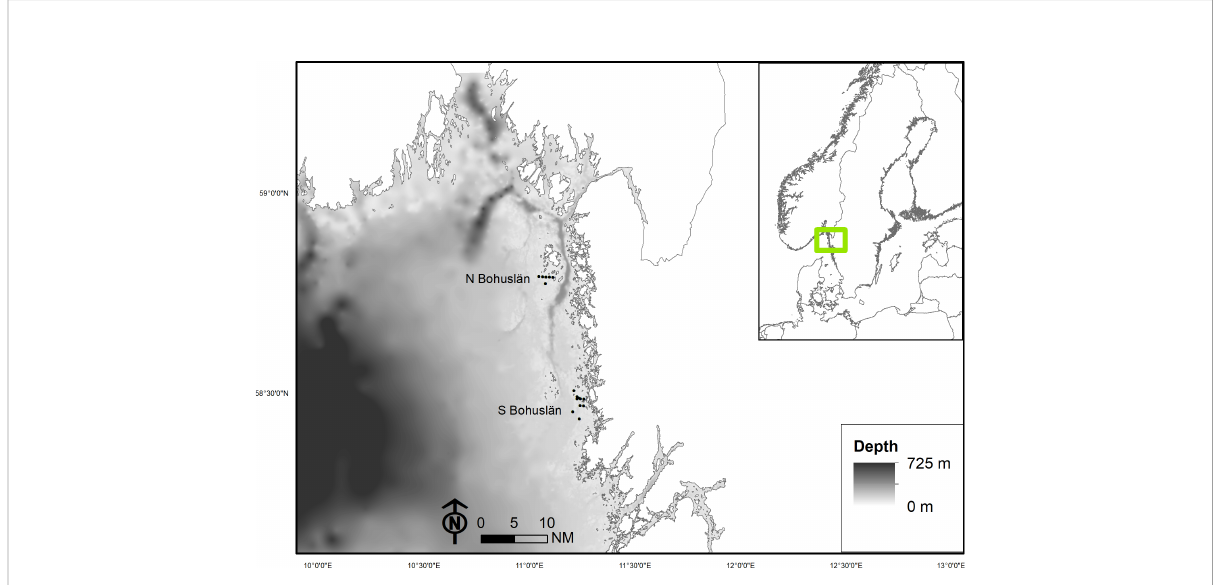
FIGURE 2 A bathymetric map of the study areas along the west coast of Sweden including the fi shing positions. Dots on the map represent the majority of locations where pots were set